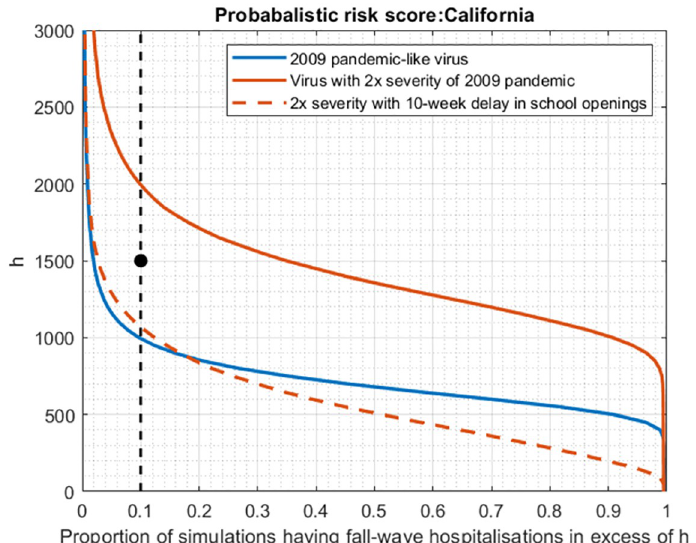
Fig 5. Proposed decision framework for triggering preemptive non-pharmaceutical interventions (NPIs), in advance of the fall wave. Shown, for illustration, is the example of California, and a proposed scenario in which school opening is postponed by 10 weeks. These plots can be interpreted as cumulative probability distributions, for the total hospitalisations projected in the fall wave. As described in the main text, we define a ‘probabilistic risk score’ (PRS) as the probability that fall wave hospitalisations will increase a given threshold, h . We assume that preemptive interventions would be triggered if PRS exceeds some threshold probability P , with both H and P determined by a policymaker. The figure shows an illustrative scenario where h = 1, 500 cumulative hospitalisations, and P = 0.1 (‘reference point’, shown as a black dot). Any model-based projections can be represented as a downward-sloping curve on this plot: preemptive interventions would be triggered if the curve intersects the vertical, dashed line at any point above the reference point. As examples, the blue curve shows model projections for a 2009-pandemic-like virus in California (i.e. corresponding to Fig 3A), a scenario that would not trigger preemptive interventions. The solid red curve shows an alternative scenario, of a virus that is equally infectious, but twice as severe (i.e. having twice the risk of hospitalisation given infection). Such a virus would trigger preemptive interventions; the dashed red curve shows the reduction in hospitalisation risk that would occur, in a scenario where school opening is postponed for 10 weeks until vaccine rollout is underway (assuming the same vaccine introduction and rollout scenario as occurred in 2009–2010, in response to the pandemic).